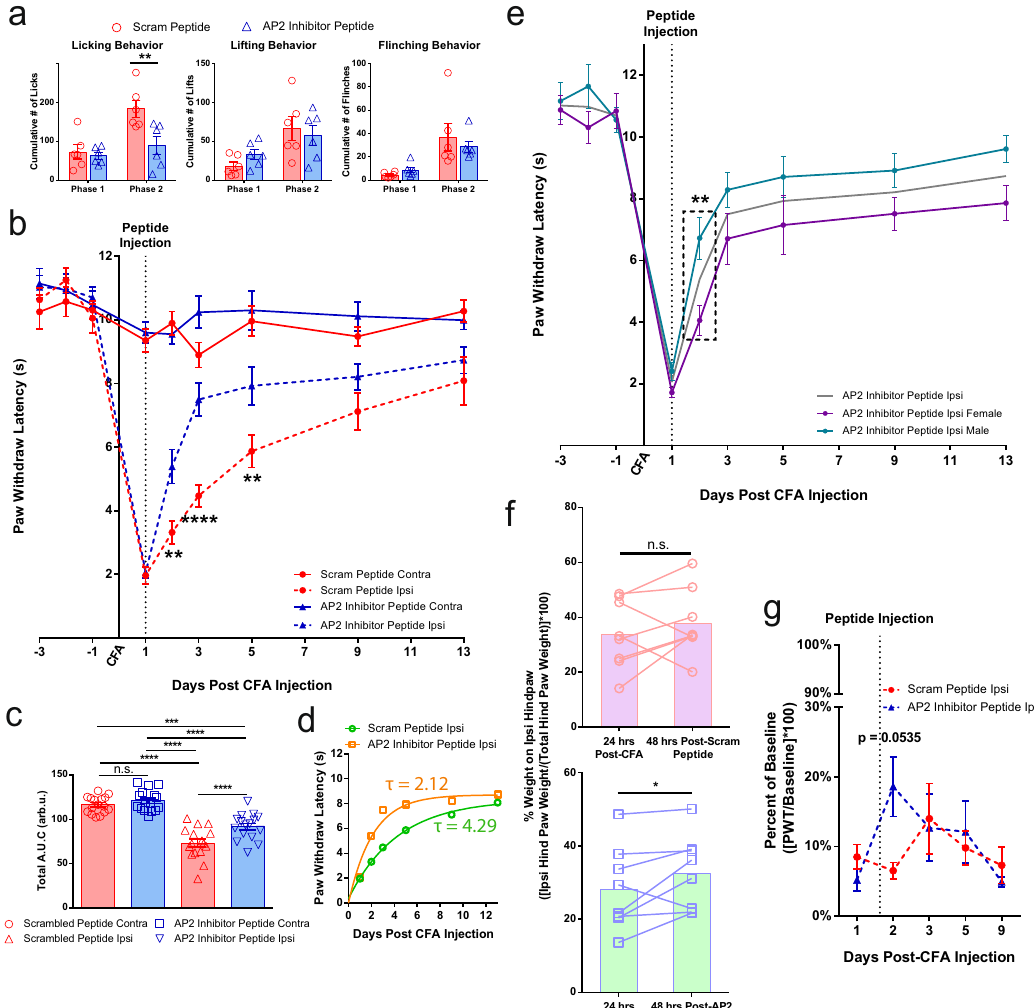
Fig. 5C; τ control = 8.12, τ AP2 = 2.85, Female: Supplementary Fig. 5F; τ control = 12.73, τ AP2 = 5.24). In contrast to the CFA model, males and females displayed signi fi cant differences in their respective paw withdrawal latencies 24 h following injection; females in the scrambled peptide group displayed less paw withdrawal latencies 24 h following incision compared to males in